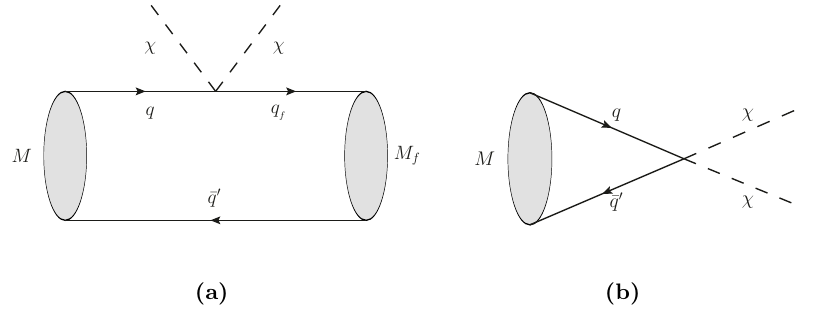
Figure 1. Feynman diagrams of decay channels involving invisible